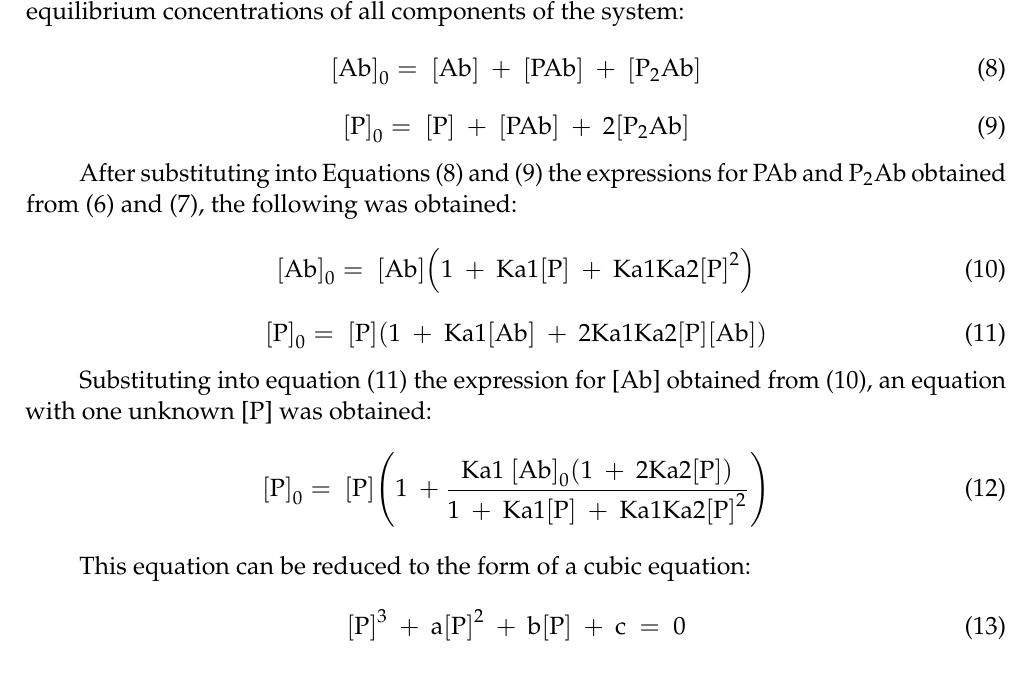
Figure 3. Kinetics of changes in the concentrations of PAb and P 2 Ab complexes (numerical model in the COPASI program). Model parameters: T = 60 s; [P] 0 = 2 × 10 − 6 M; [Ab] 0 = 10 − 6 M; ka1 = ka2 = 10 5 1/(M × s); kd1 = kd2 = 2.5 × 10 − 3 1/s. Dotted lines indicate equilibrium concentrations of [PAb] and [P 2